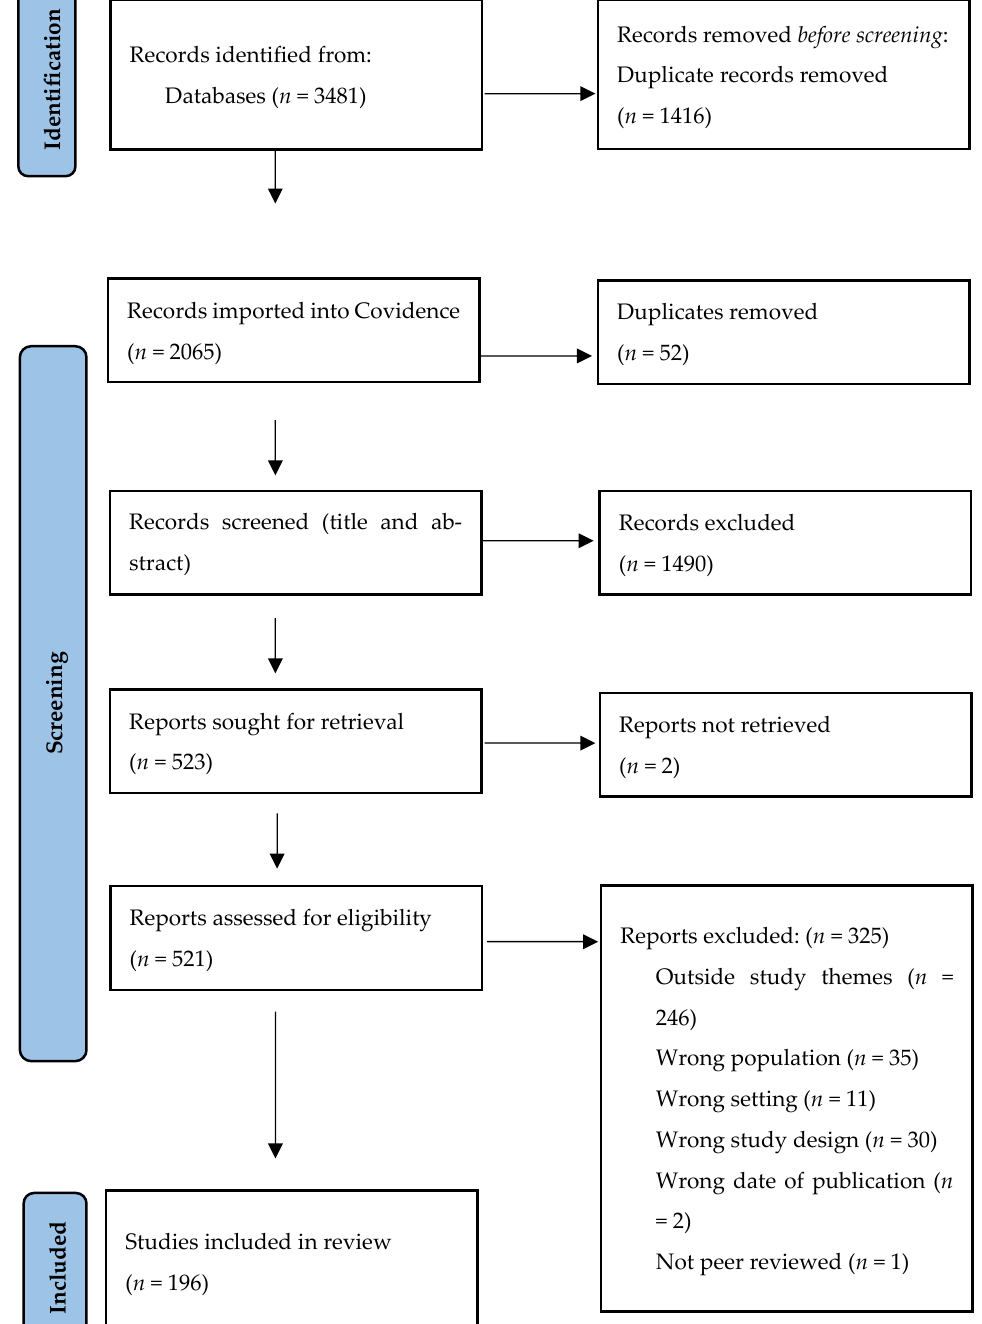
Figure 1. Prisma